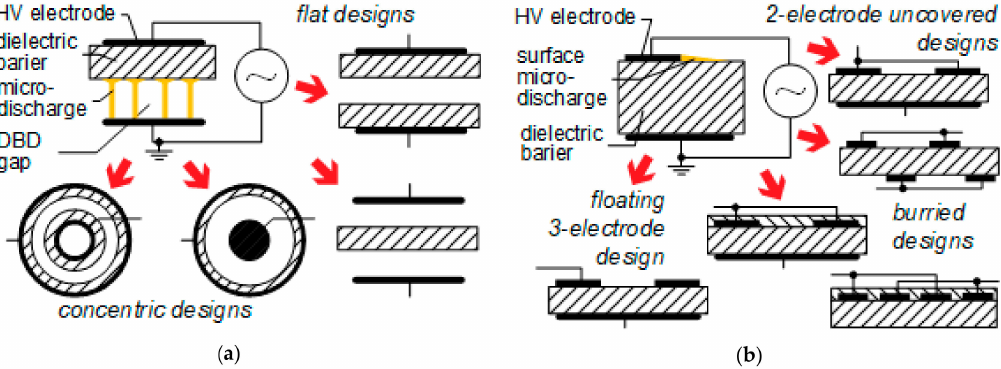
Figure 2. Schematic representation of various DBD electrode-barrier arrangement:( a ) volume DBD, ( b ) surface DBD (drawings not to